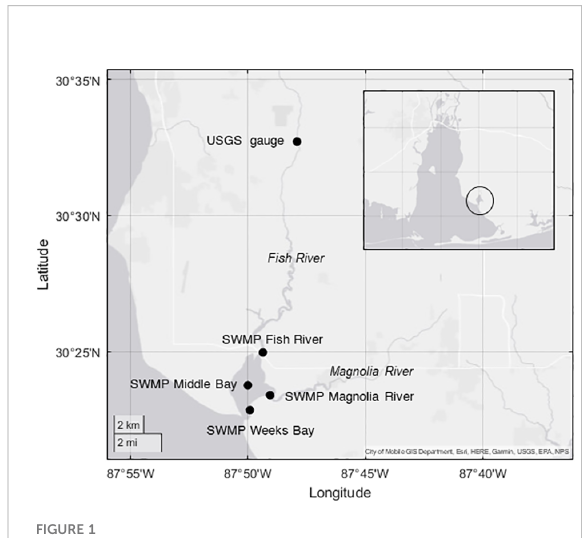
FIGURE 1 Site map of the Weeks Bay estuary. The USGS gauge is located upstream on the Fish River. The four SWMP stations were the Fish River (mean water depth = 2m), Magnolia River (1.1 m), Middle Bay (1.5 m), and Weeks Bay (0.9 m) stations. The Weeks Bay estuary is circled on the inset map of Mobile Bay,